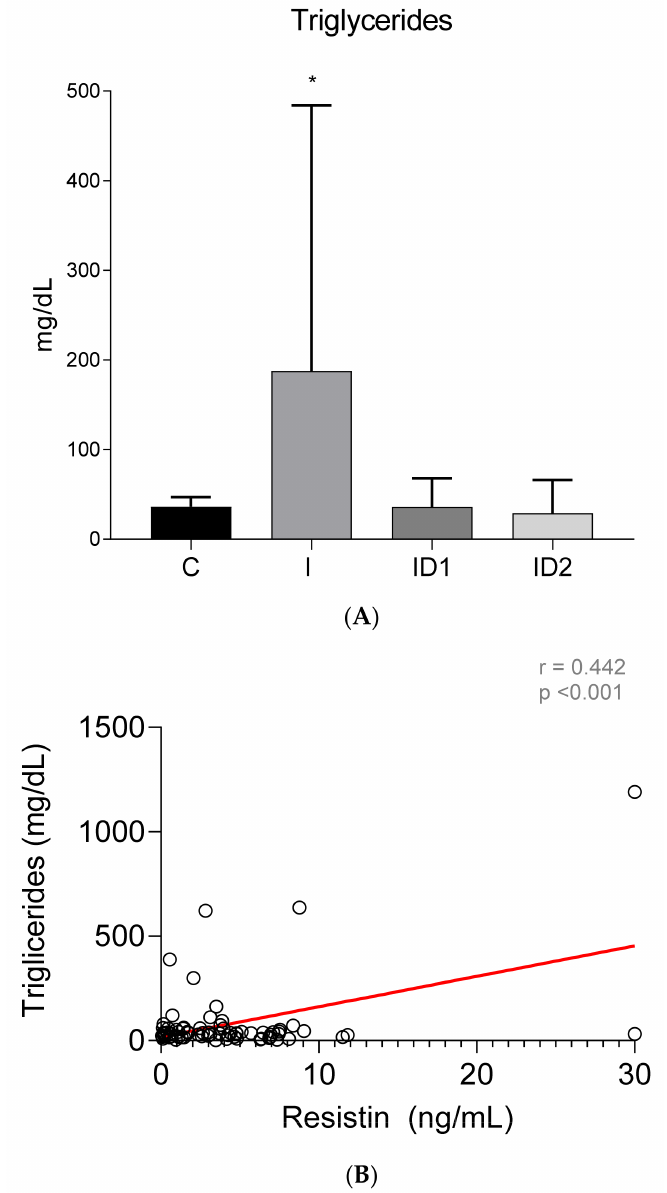
Figure 6. ( A ) Plasma triglyceride concentration (mg/dL) in the different groups. Control group (C) n = 14, inflammatory group (I) n = 21, mild insulin dysregulation group (ID1) n = 18, severe insulin dysregulation group (ID2) n = 19. Bars represent mean + SD. Asterisks indicate significant differences with the control group (* p < 0.05). ( B ) Correlation between plasma triglyceride concentration (mg/dL) and plasma resistin concentration (ng/mL) in 72 horses. The linear regression line is draw red solid (n = 72, r = 0.442, p <